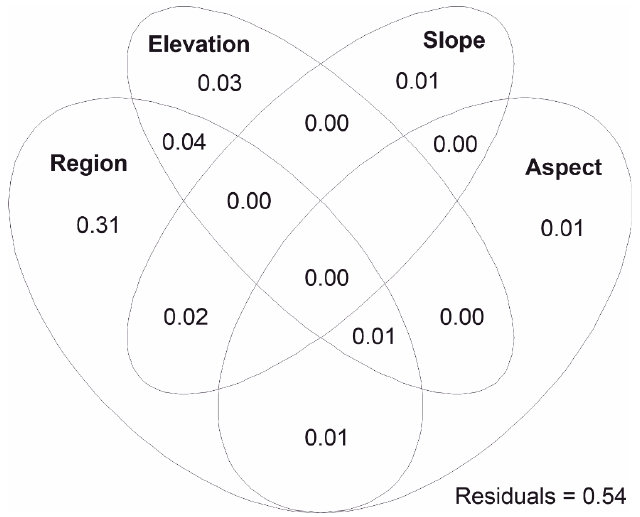
Figure 4. Partitioning of variance in compositional dissimilarity between the 89 studied communities explained by variation in elevation, slope, aspect and di ff erences in the regional species pool.